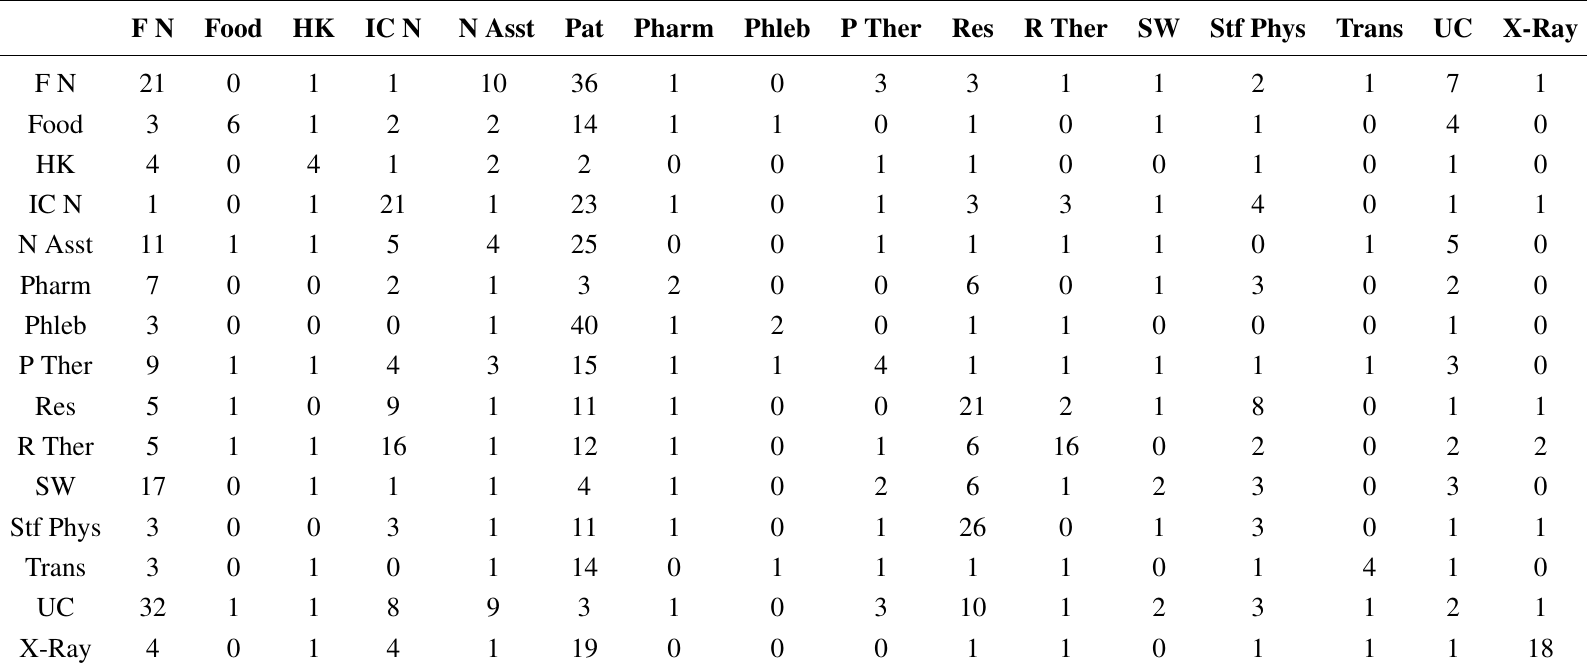
Table 2. Average contacts between worker categories per eight